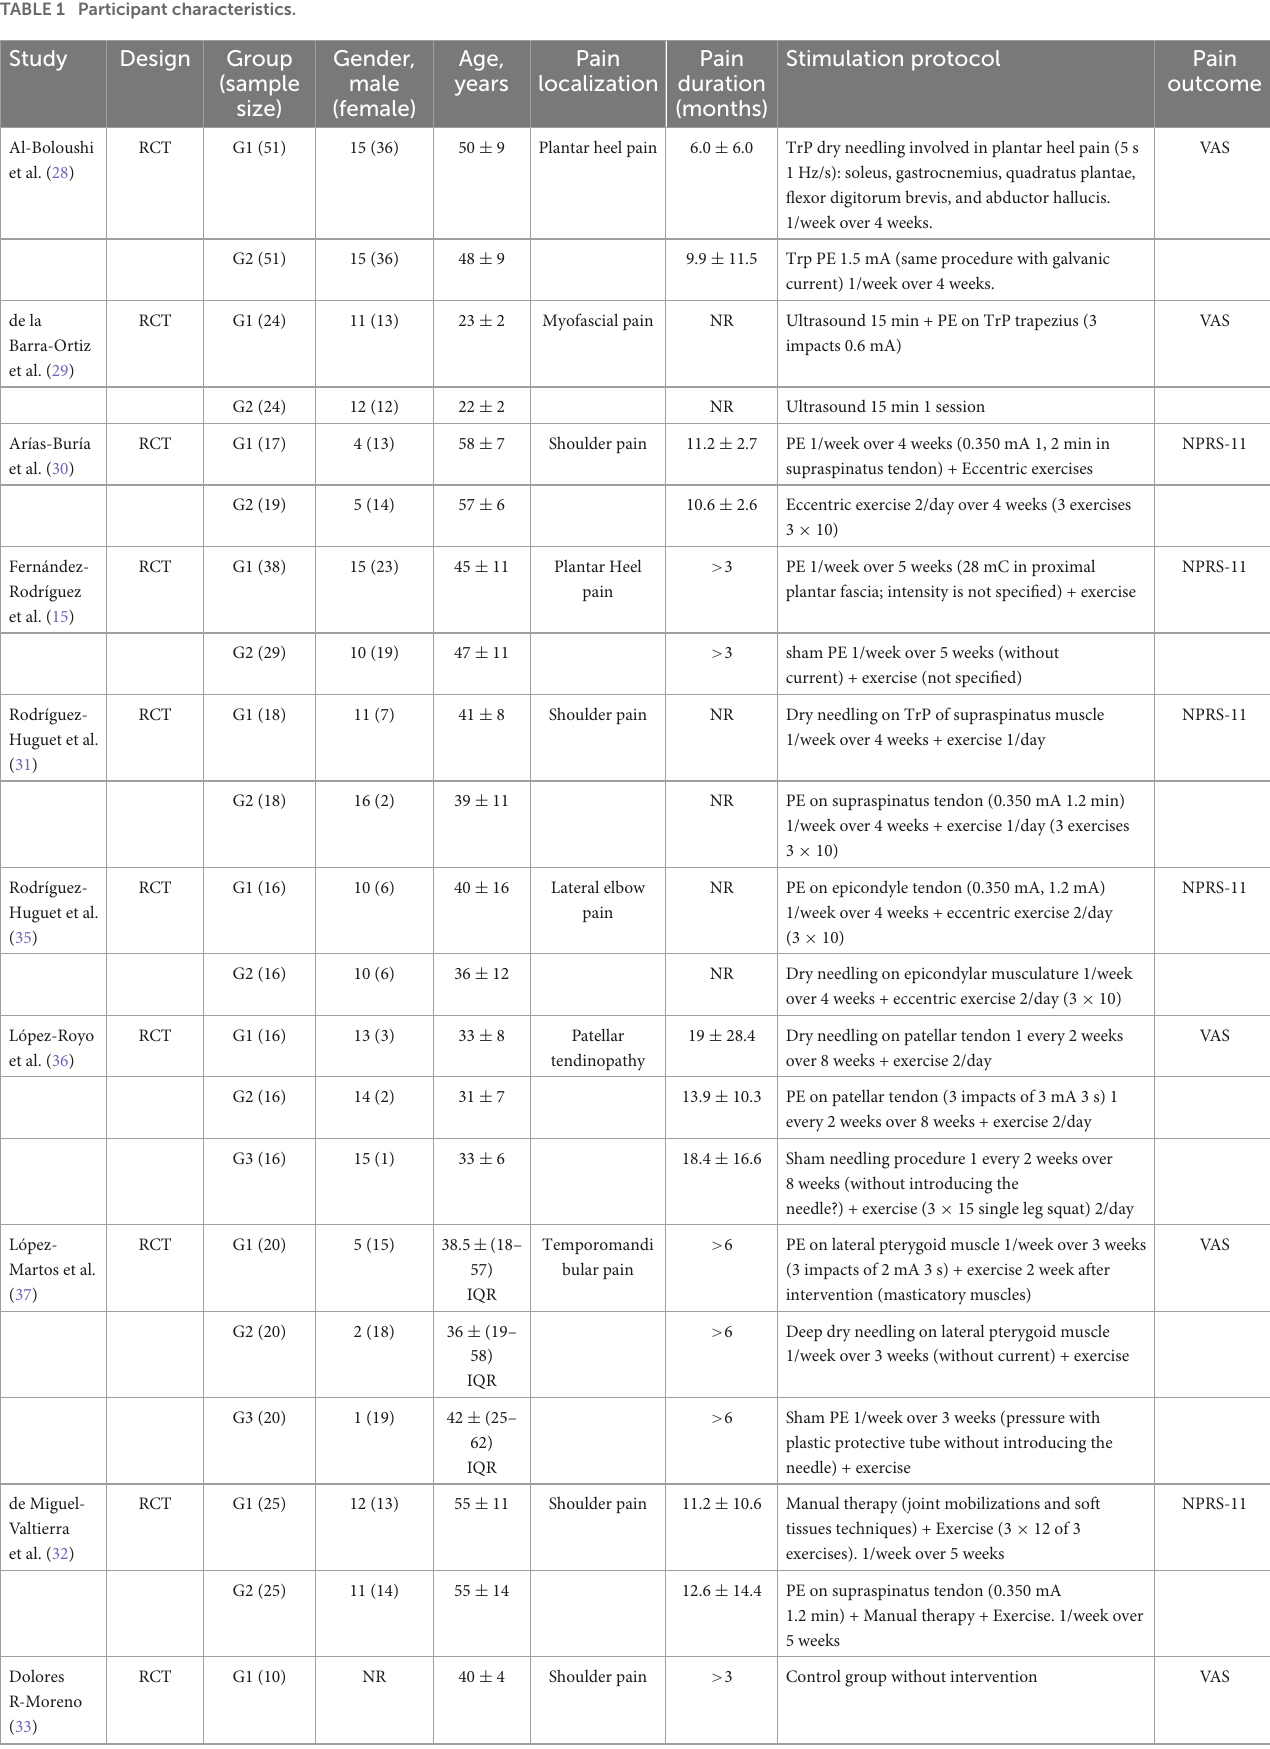
TABLE 1 Participant characteristics.